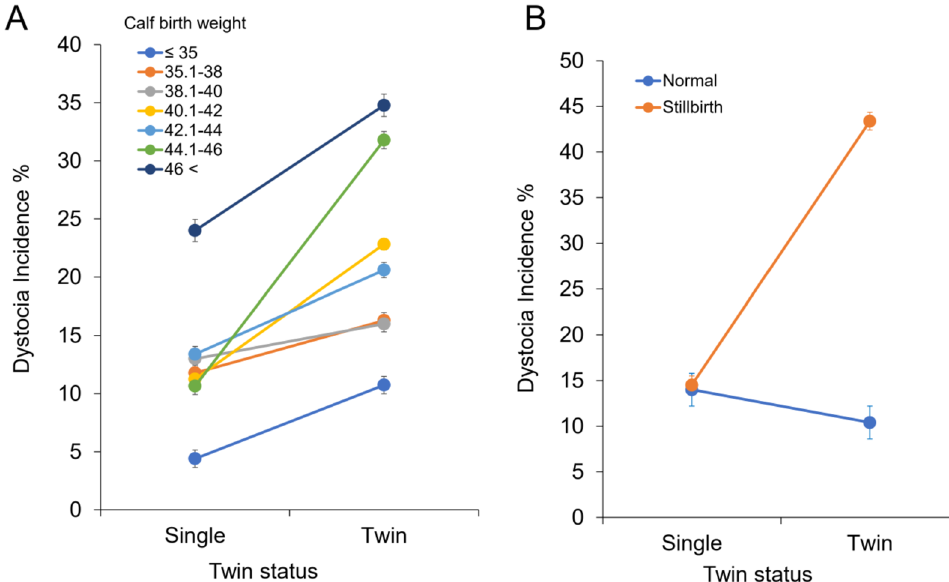
Figure 2. Interaction effects of twin status × calf birth weight ( A ) and twin status × stillbirth ( B ) were significantly associated with dystocia incidence.